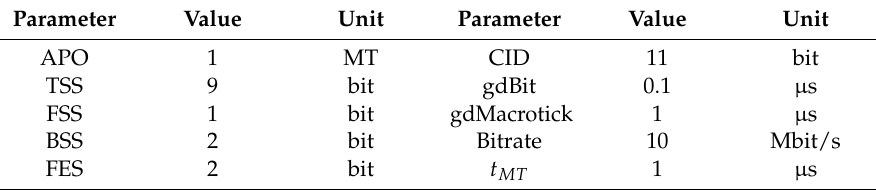
Table 3. FlexRay network parameter values.